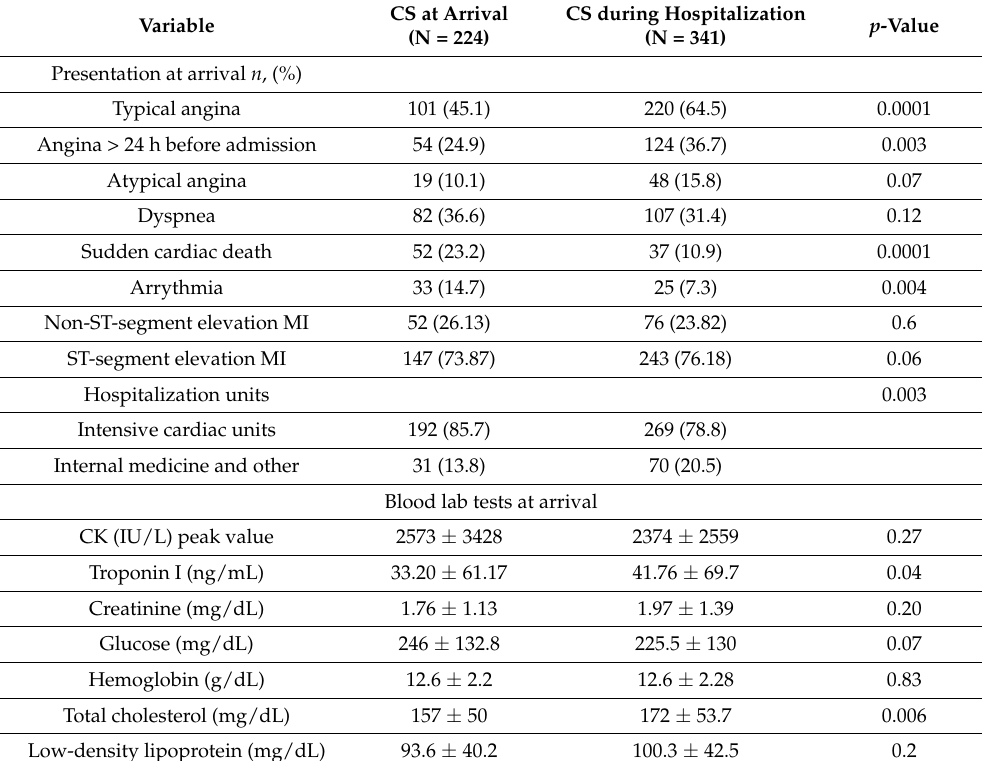
Table 2. Clinical presentations and blood lab tests of patients with ACS and CS at arrival versus patients who developed CS during hospitalization.